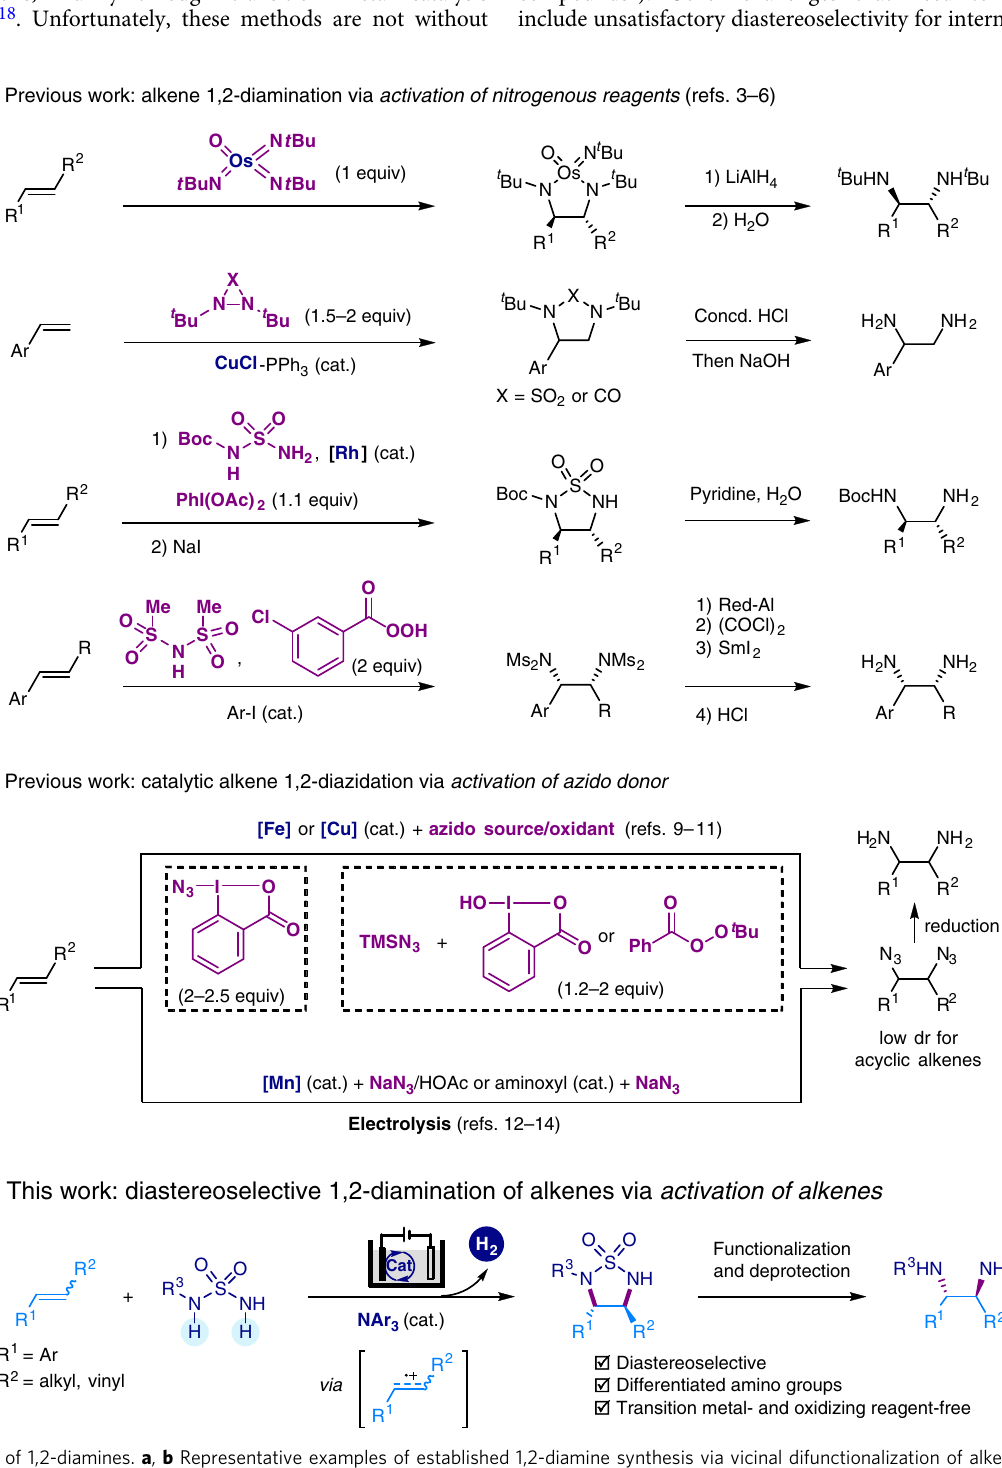
Fig. 1 Synthesis of 1,2-diamines. a , b Representative examples of established 1,2-diamine synthesis via vicinal difunctionalization of alkenes. c Proposed electrochemical 1,2-diamination of alkenes with sulfamides via dehydrogenative annulation and removal of the sulfonyl group. Boc, tert -butyloxycarbonyl; Ms, methanesulfonyl; TMS,